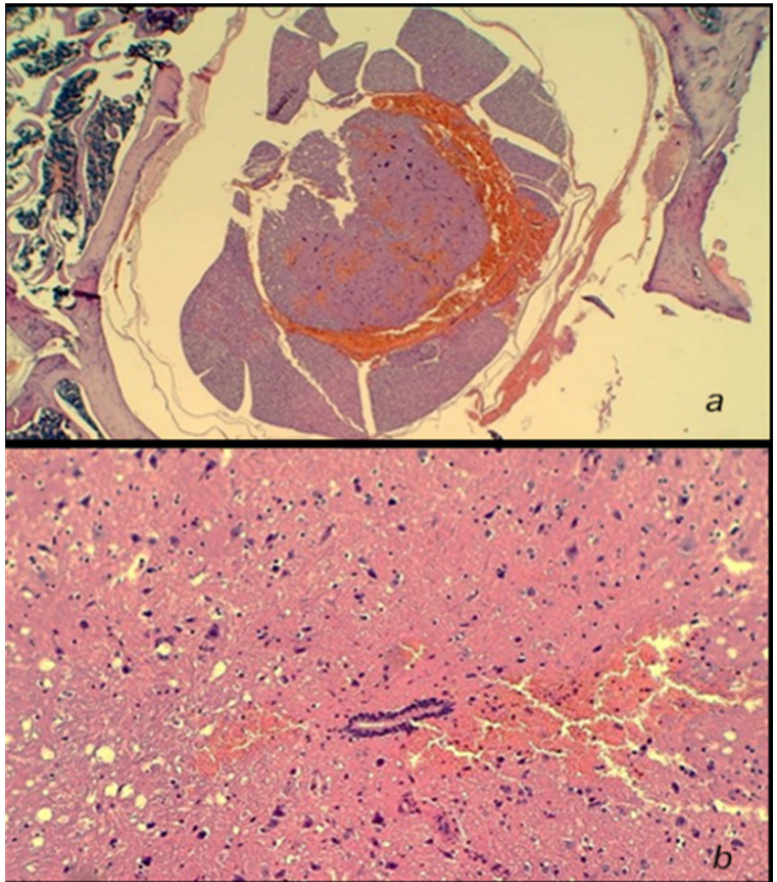
Figure 10. Neuropathological changes in the posttraumatic spinal cord and edema, and a massive hemorrhage at 10 min post-injury in the lateral and posterior white columns, as well as within the intermediate grey matter at the lesion site. HE staining; magnification 40 × (upper) ( a ) and 200 × (low) ( b ).